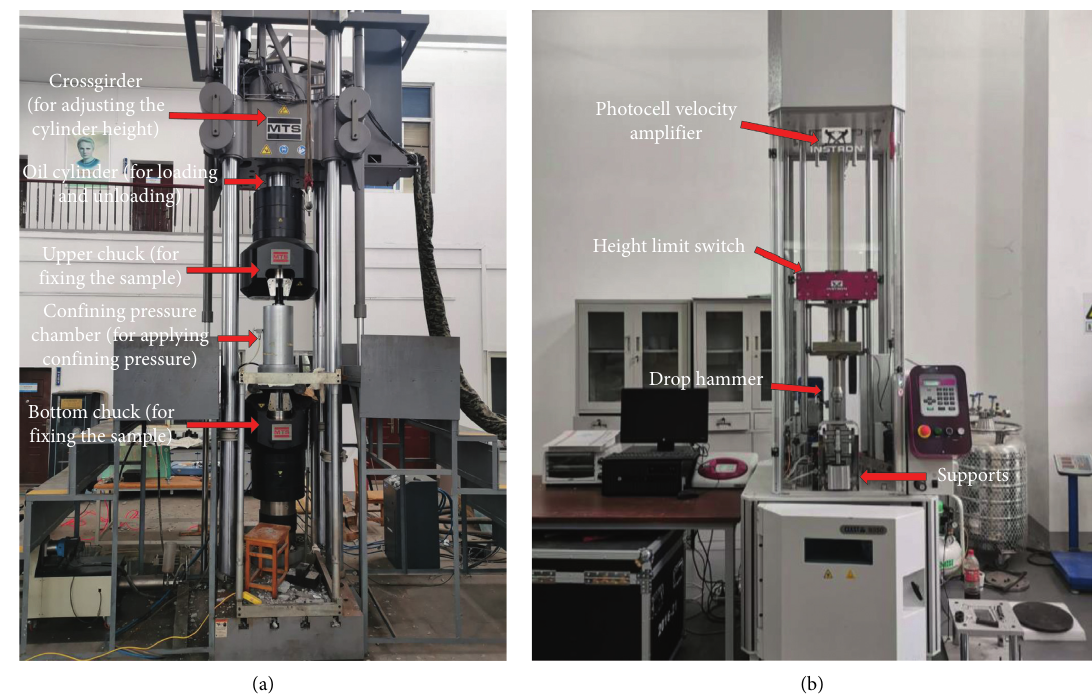
Figure 2: Experiment apparatus. (a) MTS 647.250 testing machine. (b) Drop weight impact testing machine.